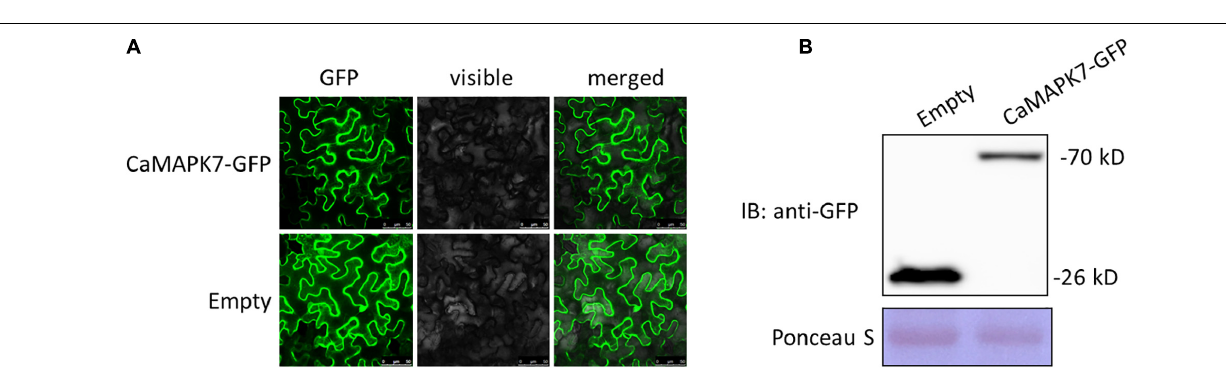
FIGURE 3 | Subcellular localization of CaMAPK7 in Nicotiana benthamiana leaves. (A) CaMAPK7-GFP, similar to the empty vector, was localized throughout the whole cells. Images were taken using Leica confocal microscopy at 48 h post-agroinfiltration. Bars = 50 µ m. (B) Immunoblot analysis of the expression of CaMAPK7 protein in N. benthamiana leaves. Immunoblotting used an anti-GFP antibody. Ponceau S was used to equal the loading. Empty, empty vector; GFP, green fluorescent protein; IB,